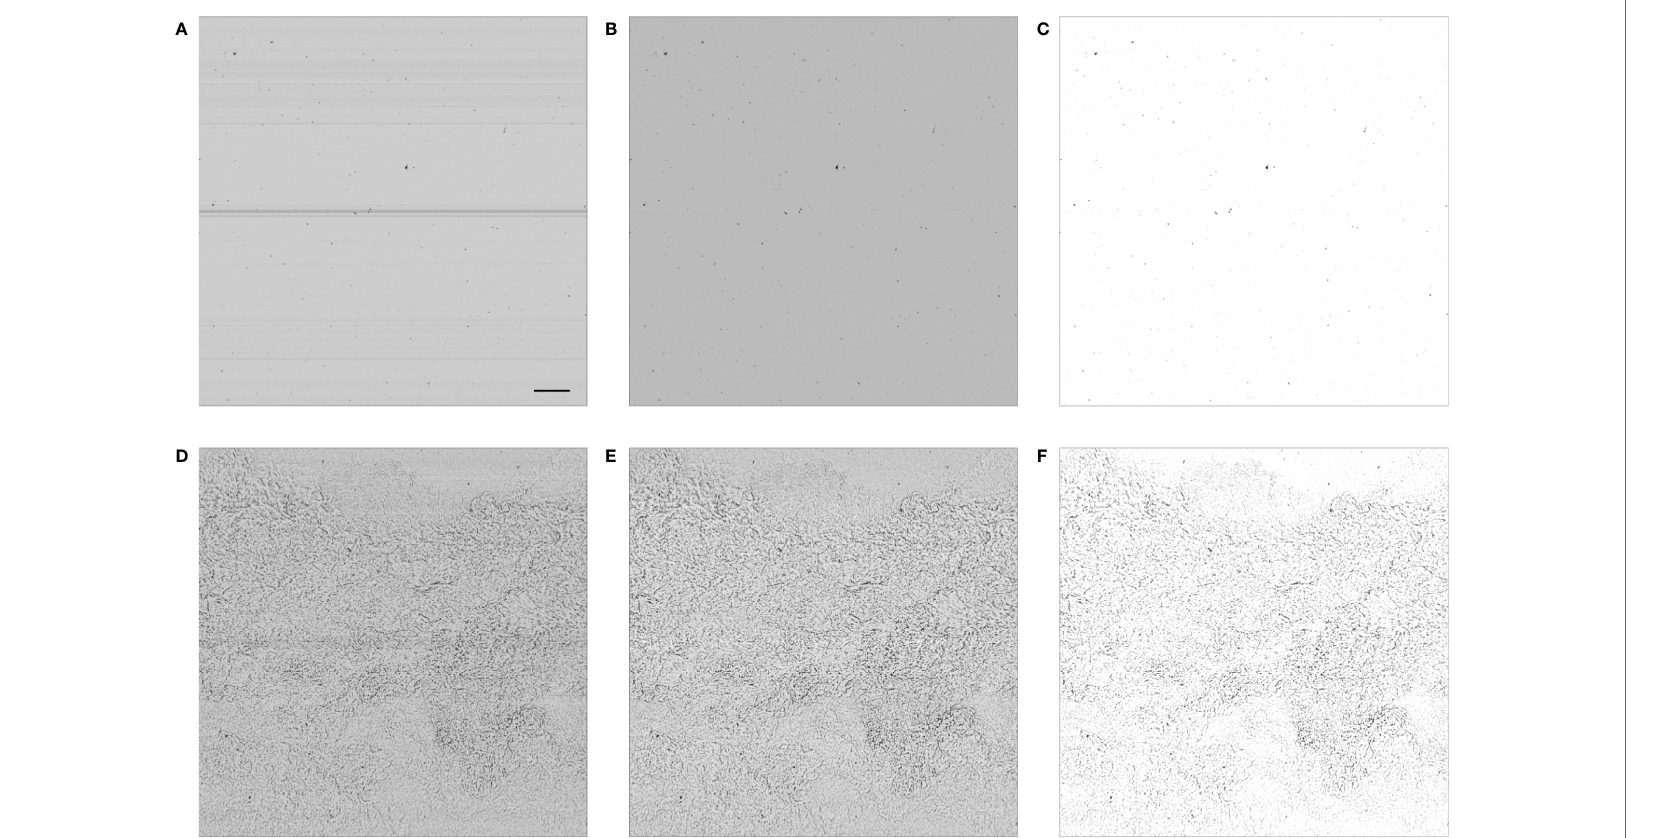
FIGURE 1 | ISIIS frames in clean waters (A – C) and across a density change (D – F) . The signature of this density change is similar to what a shadowgraph would image in air, above a burning candle. The panels are: (A, D) raw output; (B, E) after fl at- fi elding; (C, F) after contrasting. The camera scans vertically and the image is acquired from the right edge, as ISIIS moves through the water. In panel (A) , the scale bar represents 1 cm and is applicable to other